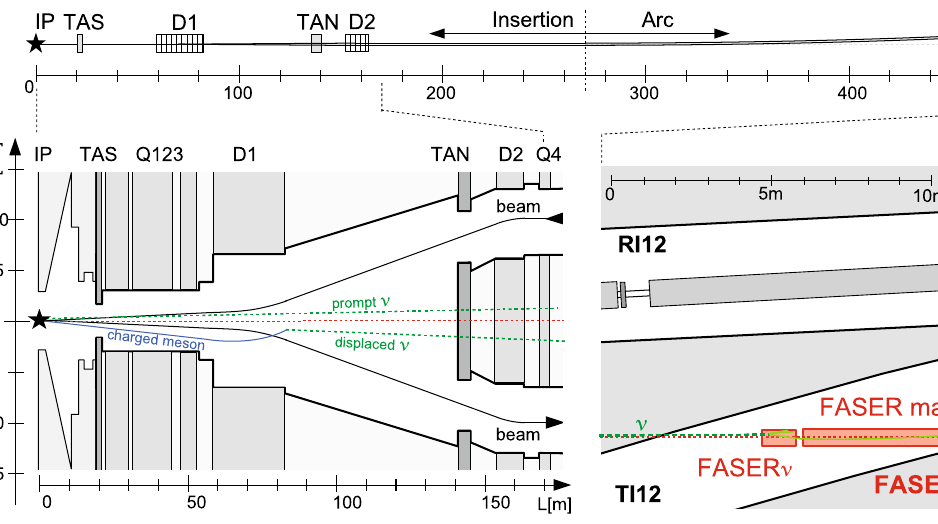
Fig. 1 Schematic view of the far-forward region downstream of ATLAS. Upper panel : FASER is located 480 m downstream of ATLAS along the beam collision axis (dotted line) after the main LHC tunnel curves away. Lower left panel : High-energy particles produced at the IP in the far-forward direction. Charged particles (solid lines) are deflected by LHC quadrupole (Q) and dipole (D) magnets. Neutral hadrons are absorbed by either the TAS front quadrupole absorber or by the TAN